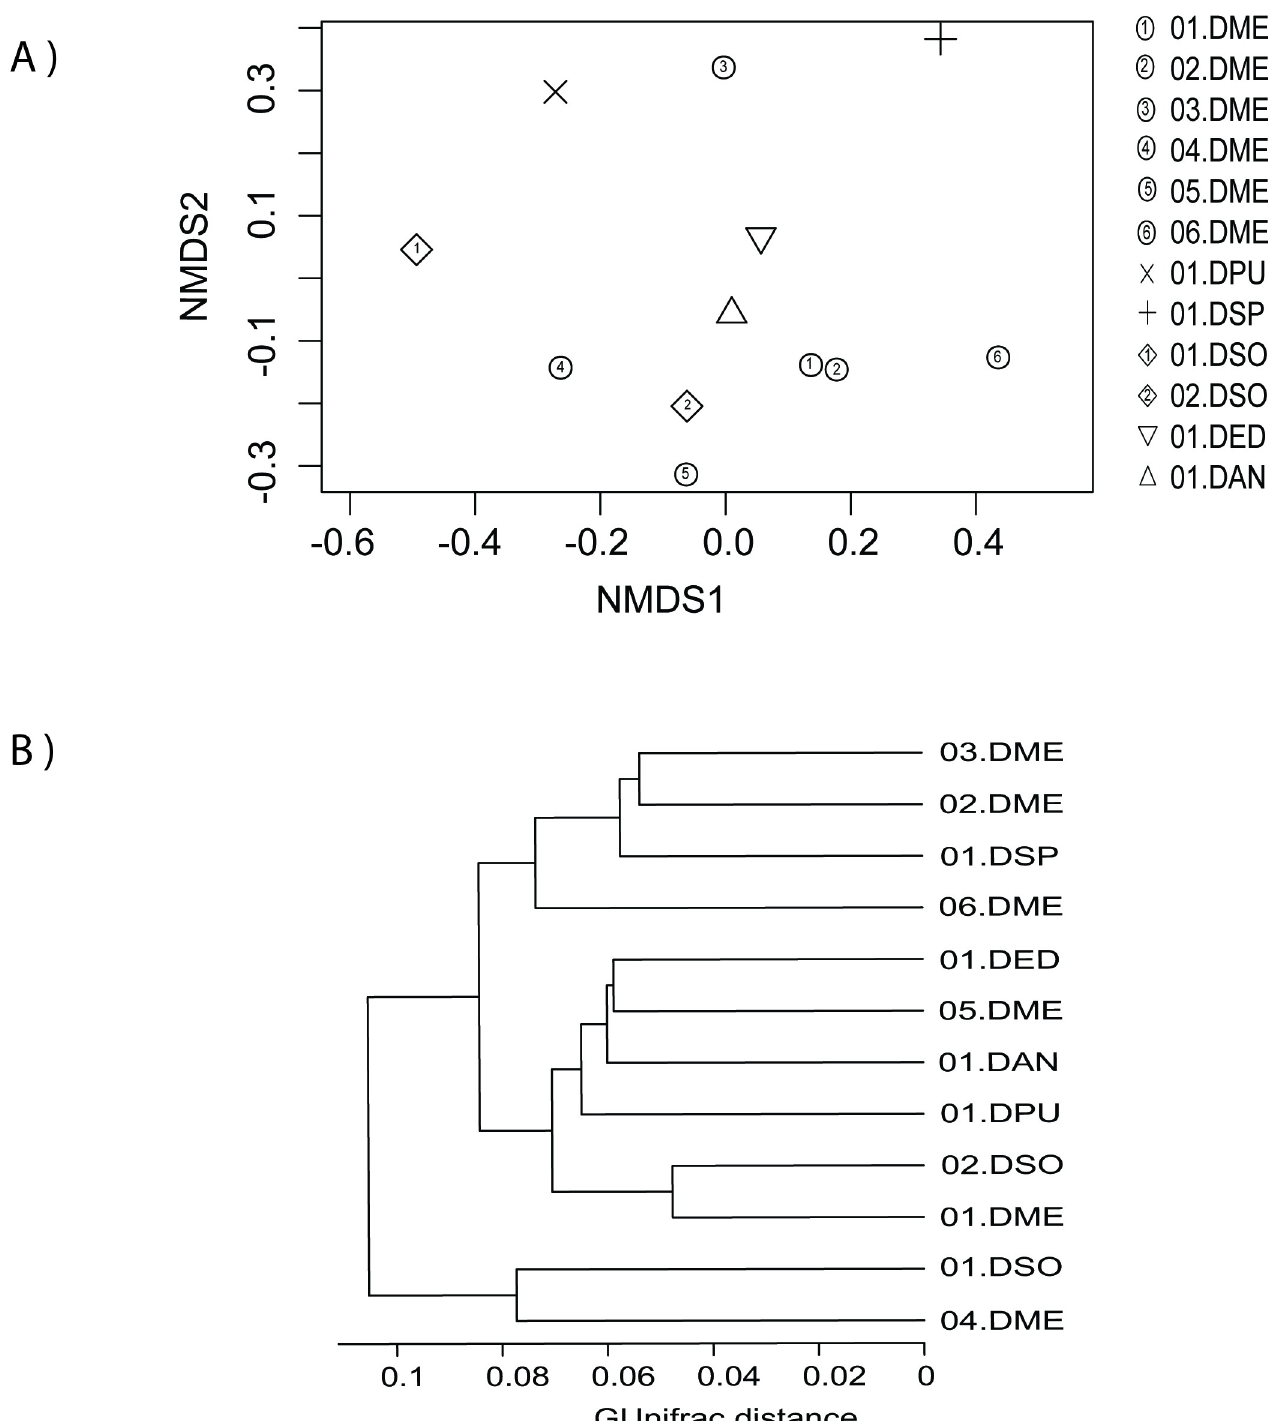
Fig 2. Beta-diversity analysis among the coralloid root endosphere from Dioon samples (set “All Dioon species” comparison). A) Non-metric multidimensional scaling (nMDS) plot based on Bray-Curtis distance, where each symbol represents the bacterial community in a single Dioon sample. B) A dendrogram based on Ward’s clustering method showing the distance and clustering of the samples by their root endosphere microbiome. Abbreviations of the Dioon species used here are: DME = D . merolae , DPU = D . purpusii , DSP = D . spinulosum , DSO = D . sonorense , DED = D . edule , and DAN = D . angustifolium